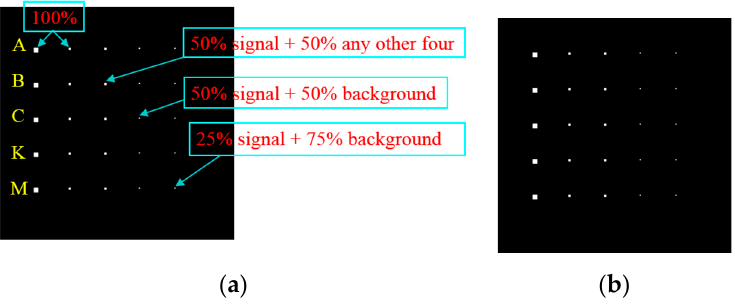
Figure 5. Synthetic dataset. ( a ) Synthetic image; ( b ) Ground truth map.